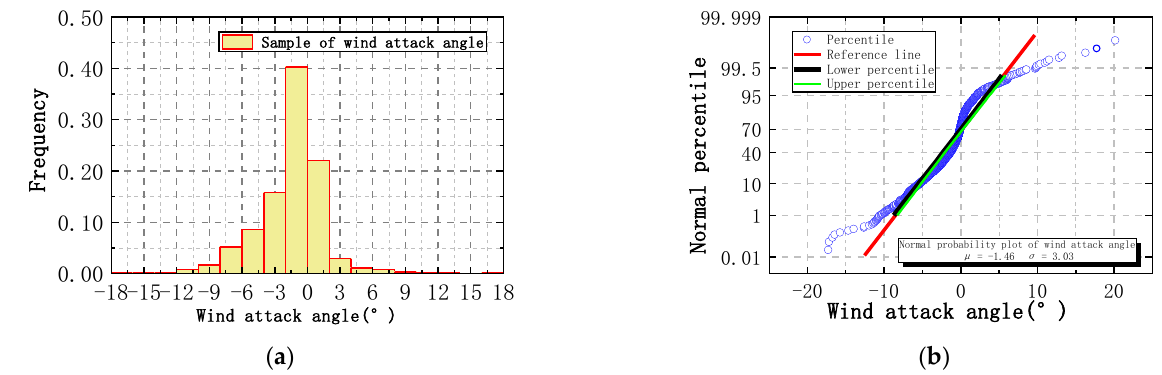
Figure 13. Frequency statistics of wind attack angle: ( a ) frequency distribution of wind attack angle; ( b ) normal probability diagram of wind attack angle at a 30 m height.